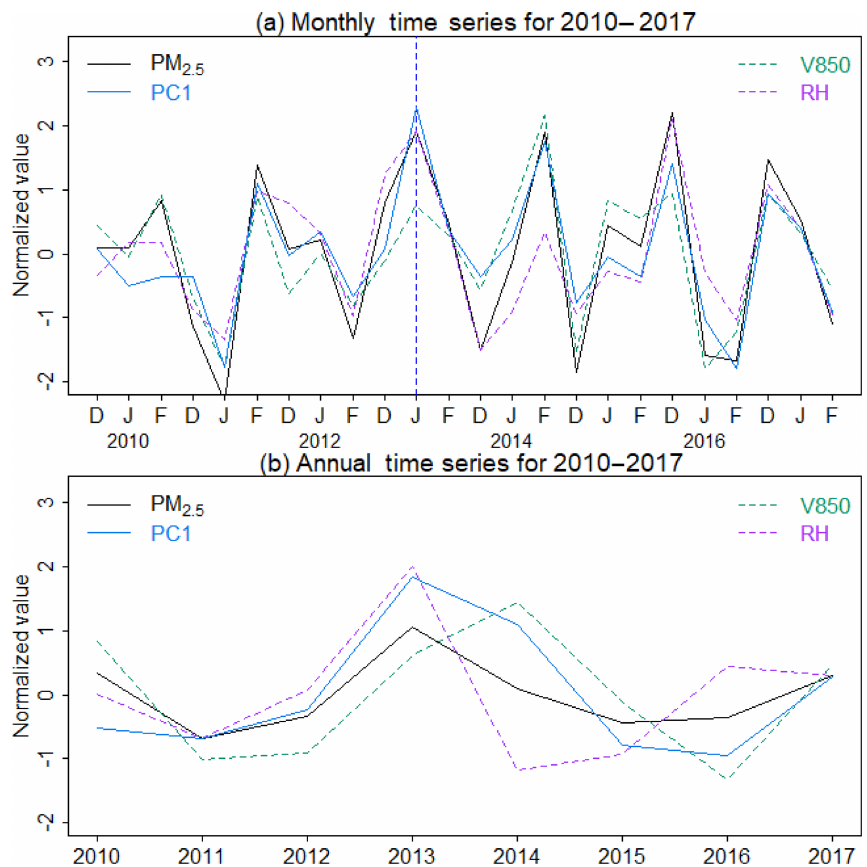
Figure 3. (a) Monthly mean time series for 2010–2017 of normalized PC1, PM 2 . 5 , V850, and RH. The normalization is relative to the 2010–2017 means; (b) same as (a) except for yearly means.